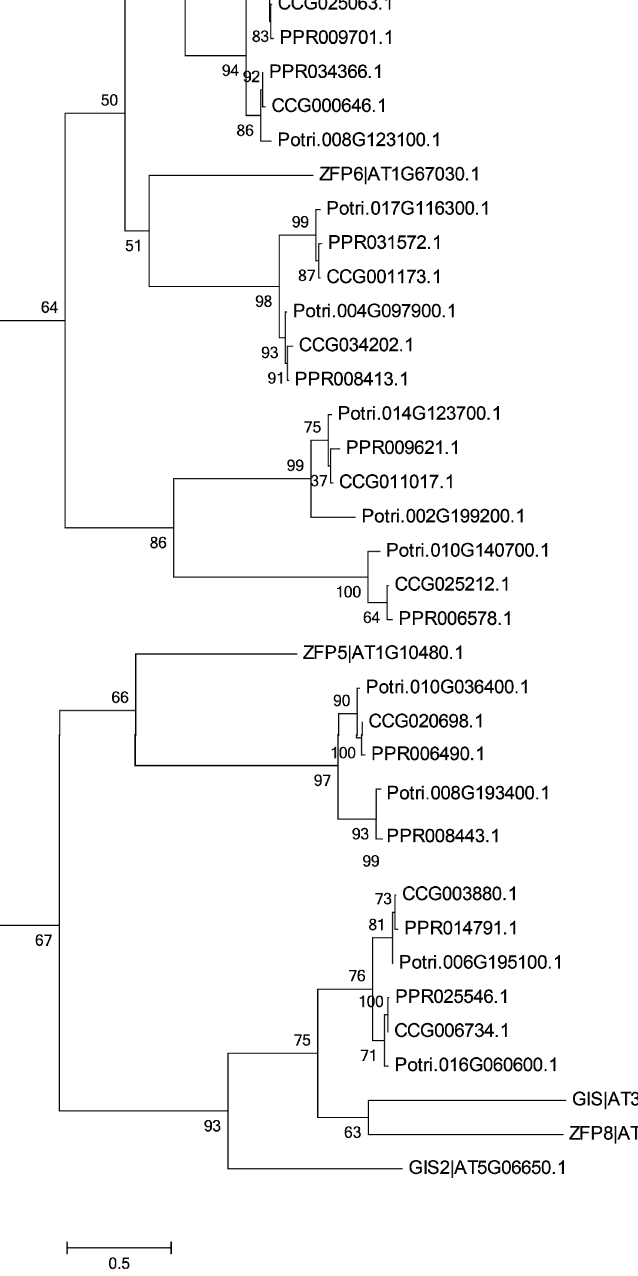
Figure 2. Phylogenetic relationships of C2H2 transcription factors (TFs) from Arabidopsis , P. trichocarpa , P. pruinosa , and P. euphratica . The phylogenetic tree was built using the maximum likelihood method implemented in RAxML. Homology of genes between Arabidopsis and the three poplars was confirmed using the tree.